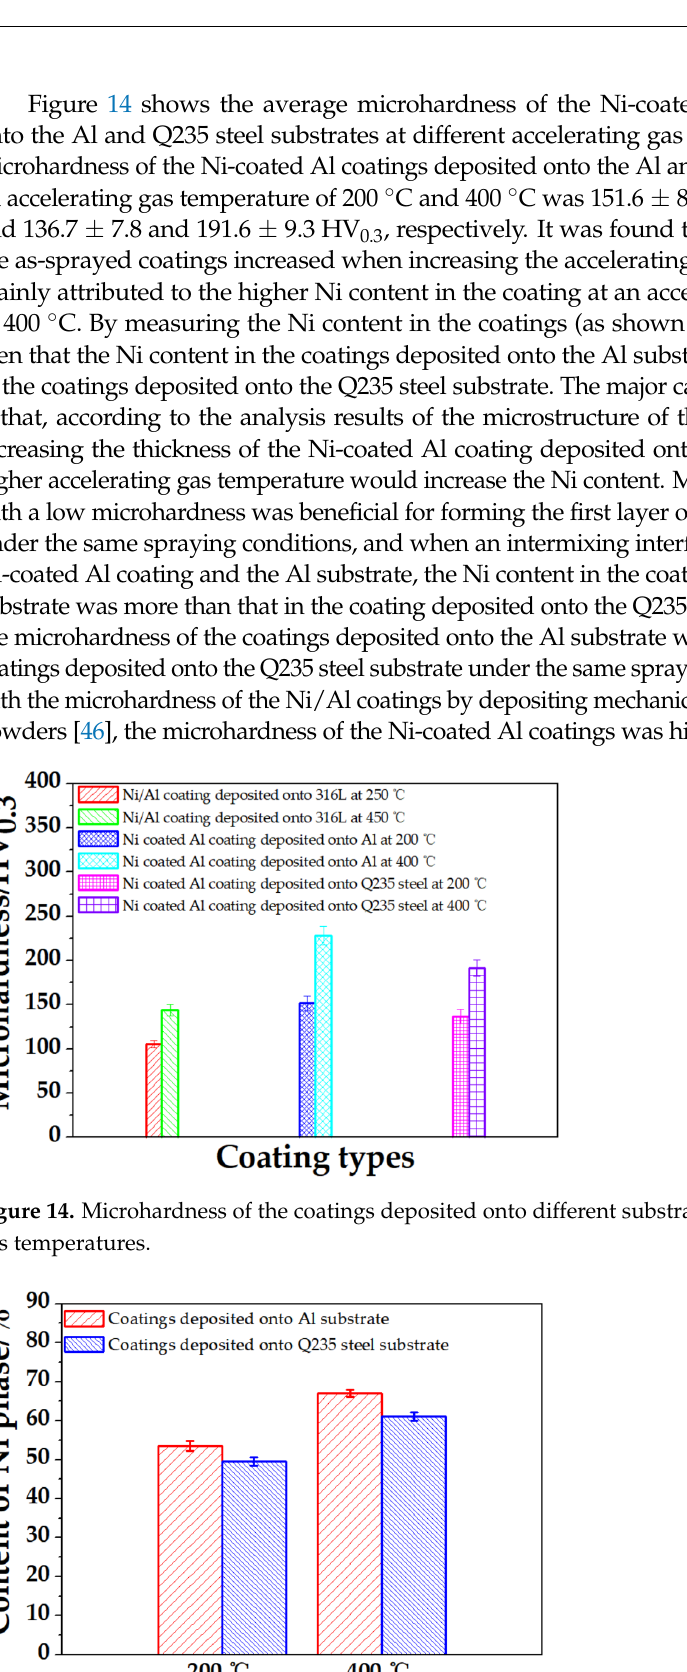
Figure 15. The content of the Ni phase in the coatings deposited onto different substrates at different accelerating gas temperatures.